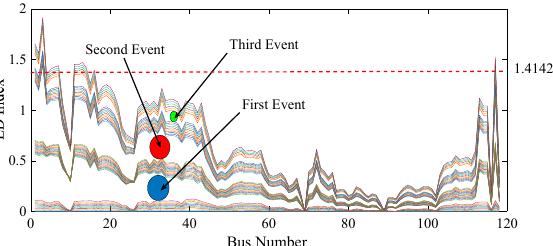
Figure 22. The response of the ED index for the case including three events related to the bus number